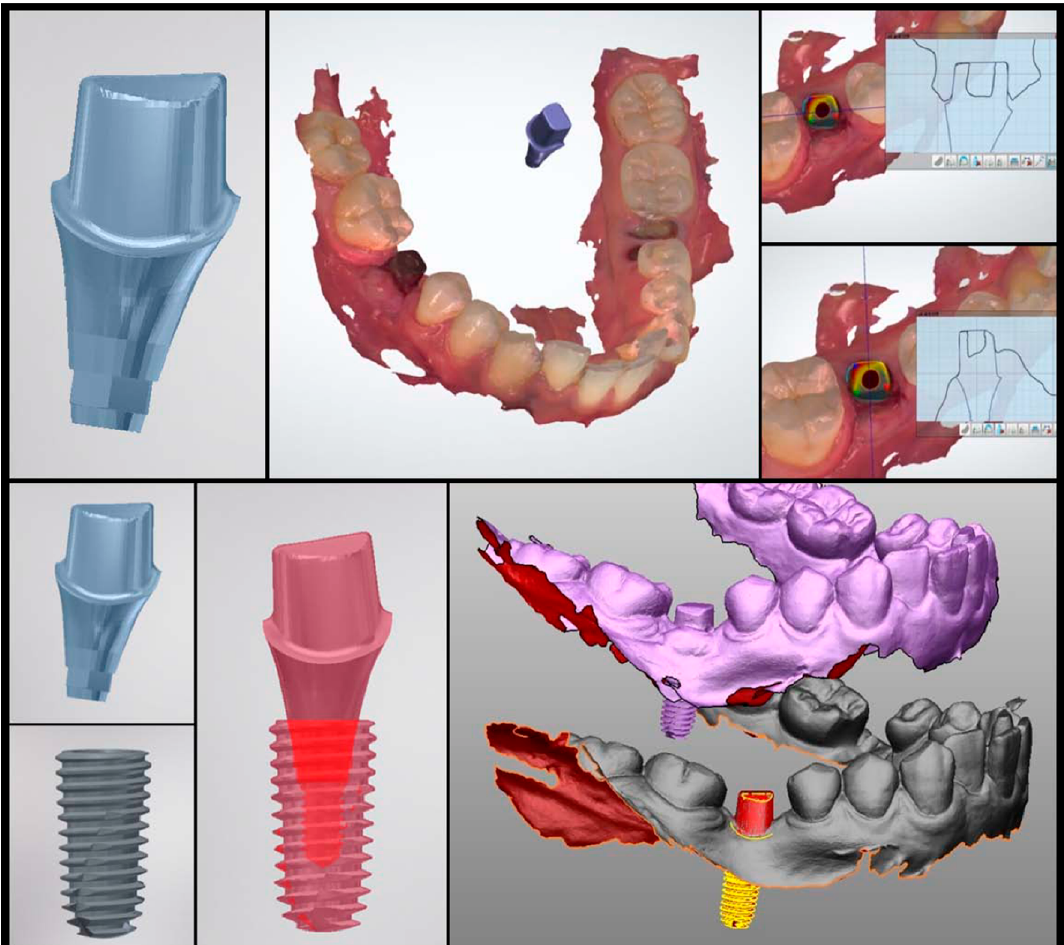
Figure 4. A custom abutment prefabricated to the planned position of the implant can be used as the scan body. By connecting this scan body to the implant and performing an intraoral scan, the actually placed position of the implant can be indirectly